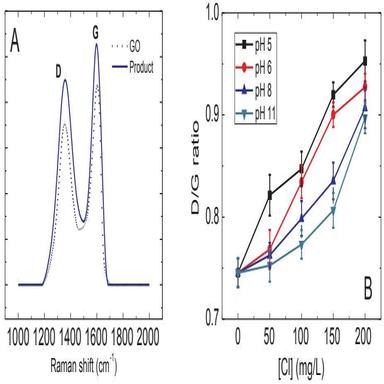
Raman spectra of GO and product. 4A: GO before and after reaction with 200 mg/L free chlorine at pH 5 under UV irradiation (2000 µW/cm2 ). 4B: D/G ratio of GO after reaction with free chlorine at different pH levels under UV irradiation (2000 µW/cm2 ) for 2 h.